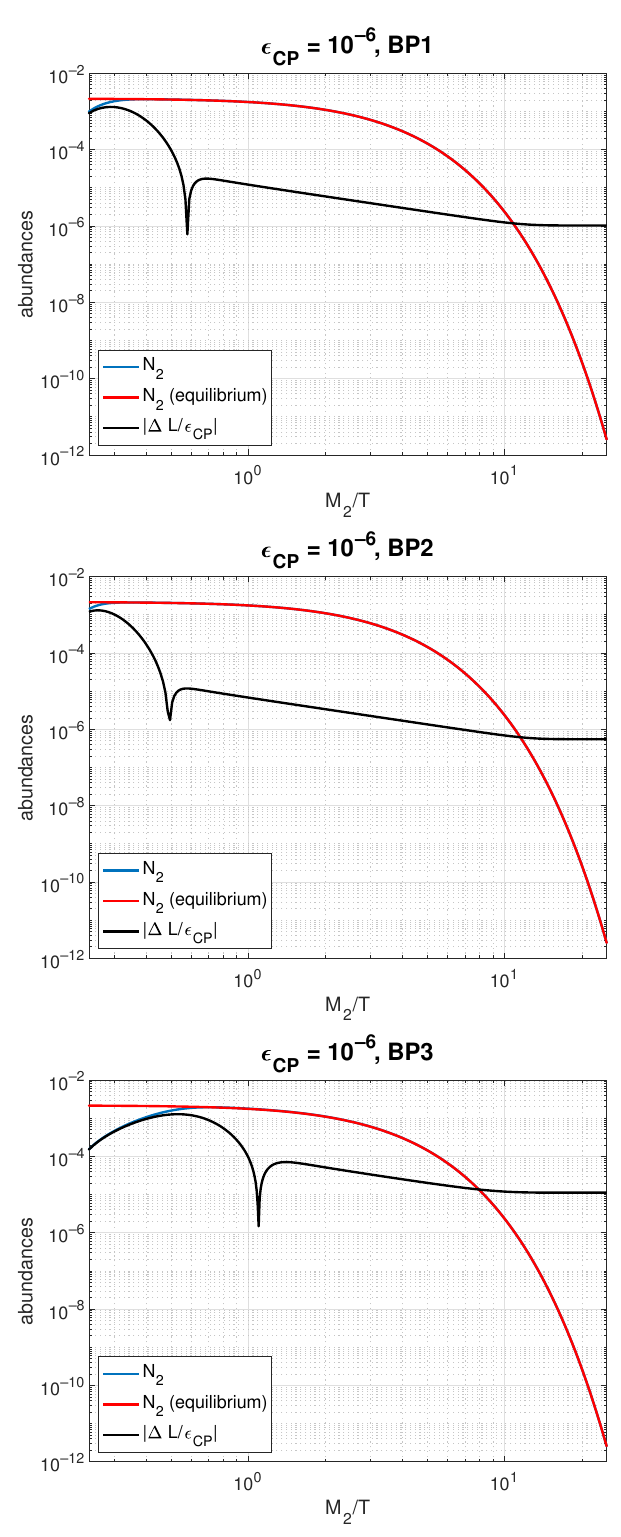
Figure 4. The evolution of the “abundance” of N 2 in blue, the “abundance” of N 2 in thermal equilibrium in red, and the lepton asymmetry generated by the CP violating decays and inverse decays of N 2 divided by the CP asymmetry parameter ε CP in black. T is the temperature of the universe in GeV, as well as the mass of heavy neutrinos M 2 in GeV. ∆ L is the number of changes in lepton number over entropy density s